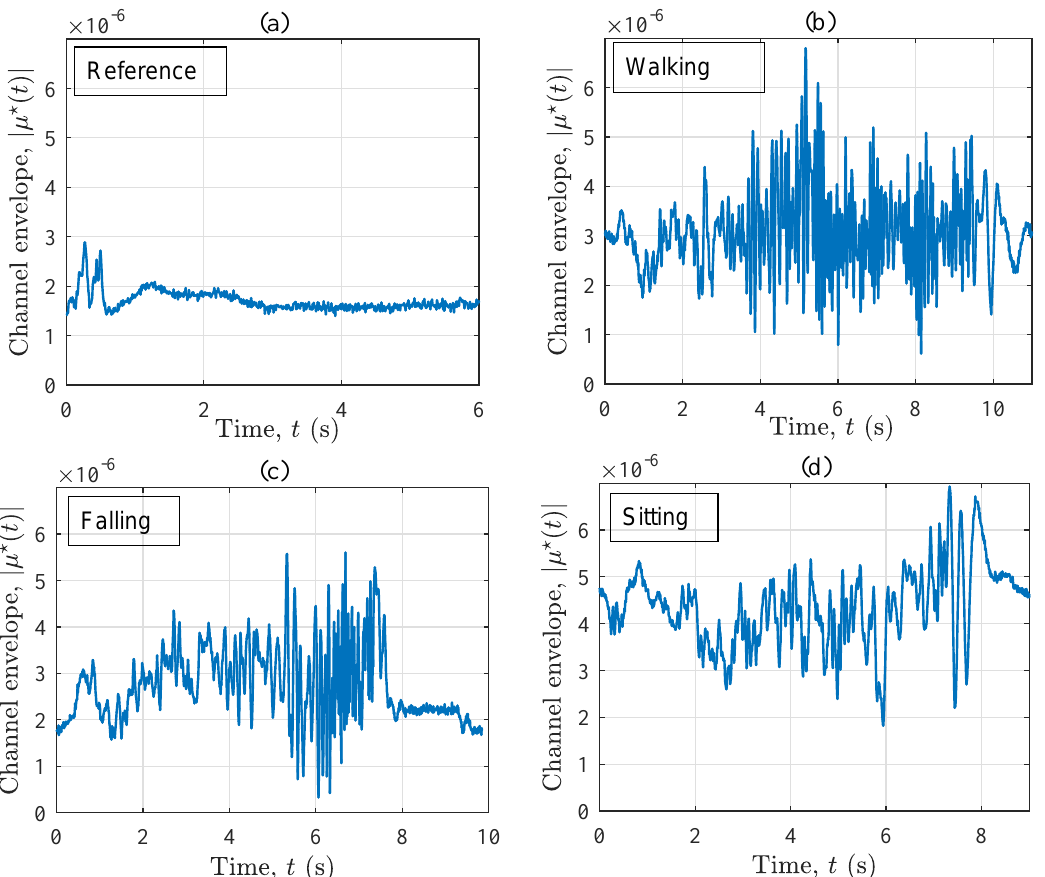
Figure 7. The signal envelope | µ (cid:63) ( t ) | for the four scenarios in S2: ( a ) reference, ( b ) walking, ( c ) falling, and ( d )